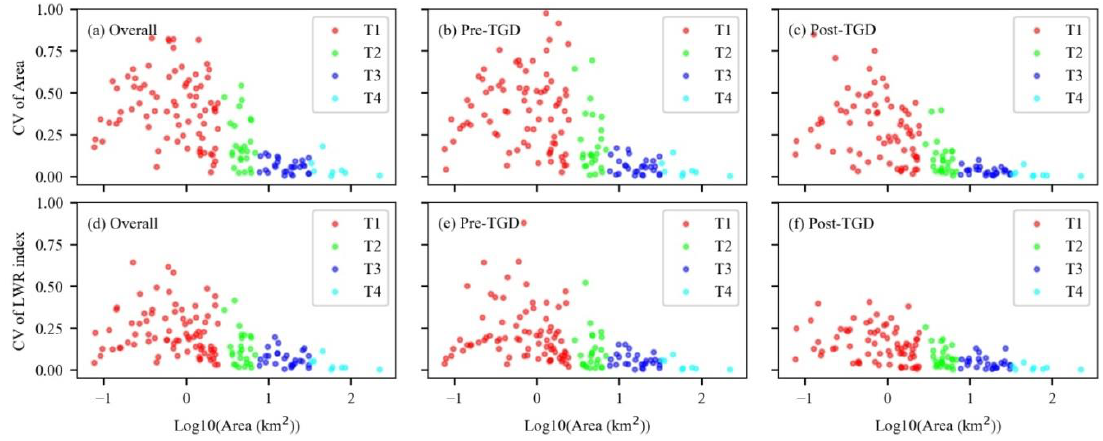
Figure 11. CV -indicated temporal stability of all individual MCBs changed with their sizes (indicated by log-transformed area) in different periods (overall, pre-TGD, and post-TGD).